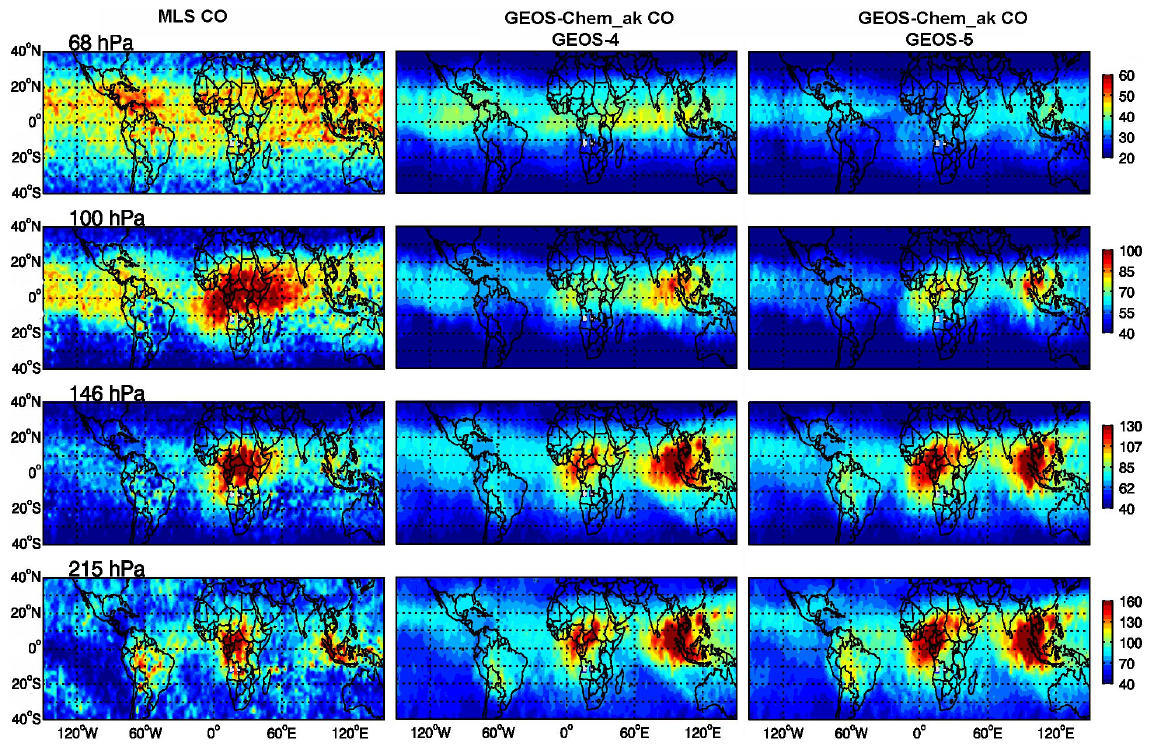
Fig. 2. Spatial patterns of monthly mean CO mixing ratios at 215hPa, 147hPa, 100hPa and 68hPa for February 2005 during the Northern Hemisphere biomass burning season from MLS (left), the GEOS-Chem model simulations driven by GEOS-4 (middle) and GEOS-5 (right) using GFED2 emissions with the MLS AKs